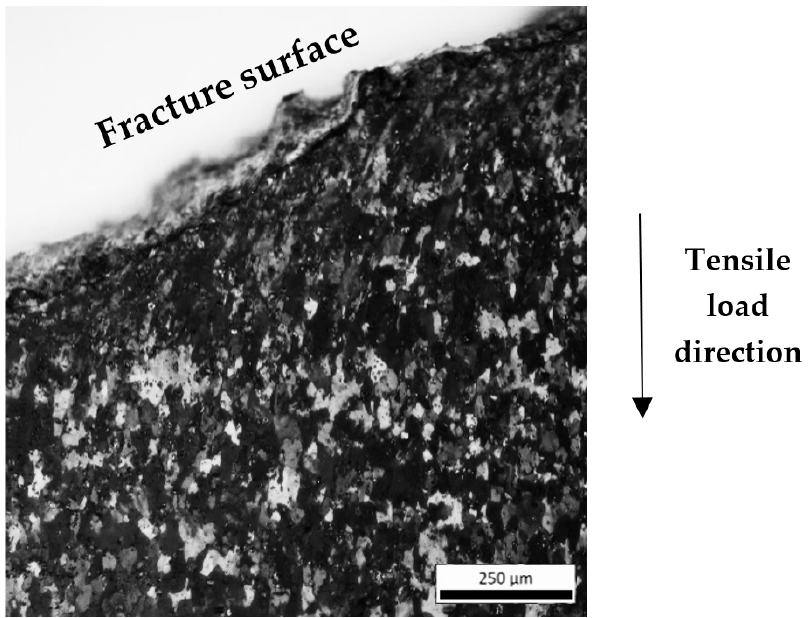
Figure 7. Indicative optical micrograph after Barkers etching of sample rx.TR. The black arrow indicated the tensile load direction.